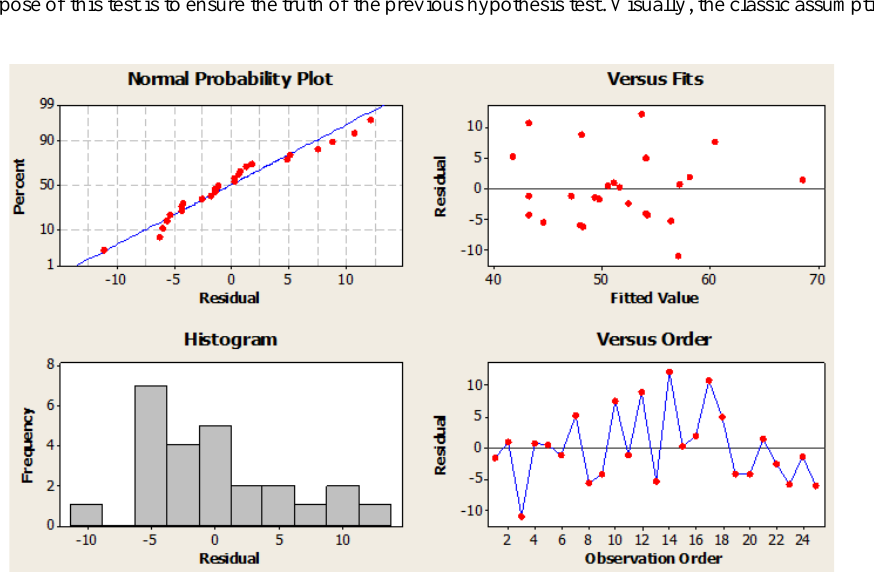
Figure 1: Classical Assumption